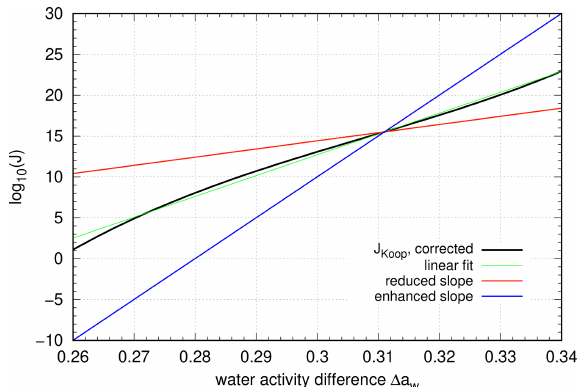
Figure 5. Artificial change in the slope of the linear function in the exponent of the nucleation rate. The fit to the reference curve is indi- cated by the green line (slope b 1 ∼ 250), a reduced slope ( b 1 ∼ 100) is displayed in red, and an enhanced slope ( b 1 ∼ 500) is displayed in